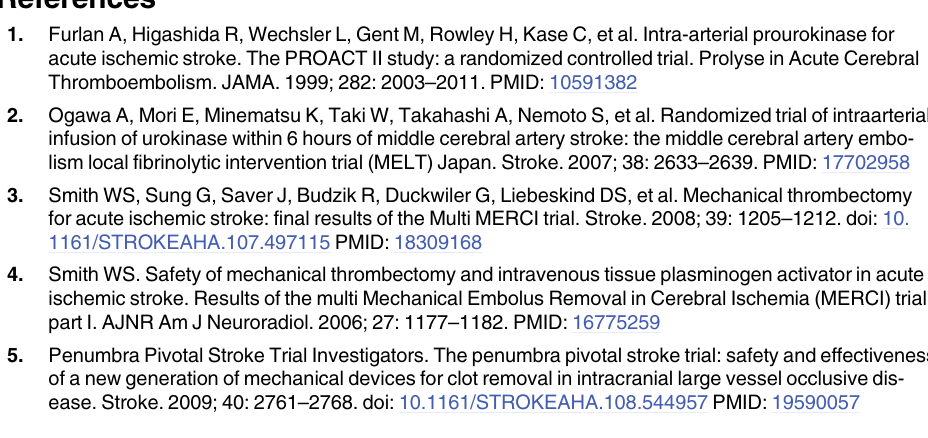
evidence. Table C: List of excluded studies. Figure A: Cumulative meta-analysis (i.e. effects over time). Figure B: Forest plots showing any intracranial hemorrhage between endovascular thera- py and controls. Figure C: Forest plot showing mortality in endovascular therapy vs controls. Figure C1: IA thrombolysis only vs mechanical device use. Figure C2: Comparator includes IV thrombolysis vs no thrombolysis. Figure C3: Studies that required vessel occlusion vs studies did not require vessel occlusion status. Figure D: Forest plot showing any intracranial hemorrhage in endovascular therapy vs controls. Figure D1: IA thrombolysis only vs mechanical device use. Figure D2: Comparator includes IV thrombolysis vs no thrombolysis. Figure D3: Studies that re- quired vessel occlusion vs studies did not require vessel occlusion status. Figure E: Forest plot showing symptomatic intracranial hemorrhage in endovascular therapy vs controls. Figure E1: IA thrombolysis only vs mechanical device use. Figure E2: Comparator includes IV thromboly- sis vs no thrombolysis. Figure E3: Studies that required vessel occlusion vs studies did not re- quire vessel occlusion status. Figure F: Funnel Plots and Egger ’ s test for asymmetry of the funnel plot (p < 0.1 for asymmetry). Figure F1: Primary outcome: Rankin < 3. Egger ’ s test: p value = 0.2. Figure F2: Secondary outcome: Mortality. Egger ’ s test: p value = 0.2. Figure F3: Secondary out- come: Any ICH. Egger ’ s test: p value = 0.03. Figure F4: Secondary outcome: Symptomatic ICH. Egger ’ s test: p value = 0.06. Figure G: Absolute risk differences (ARD) for the secondary out- comes. Figure G1: Mortality. Figure G2: Symptomatic